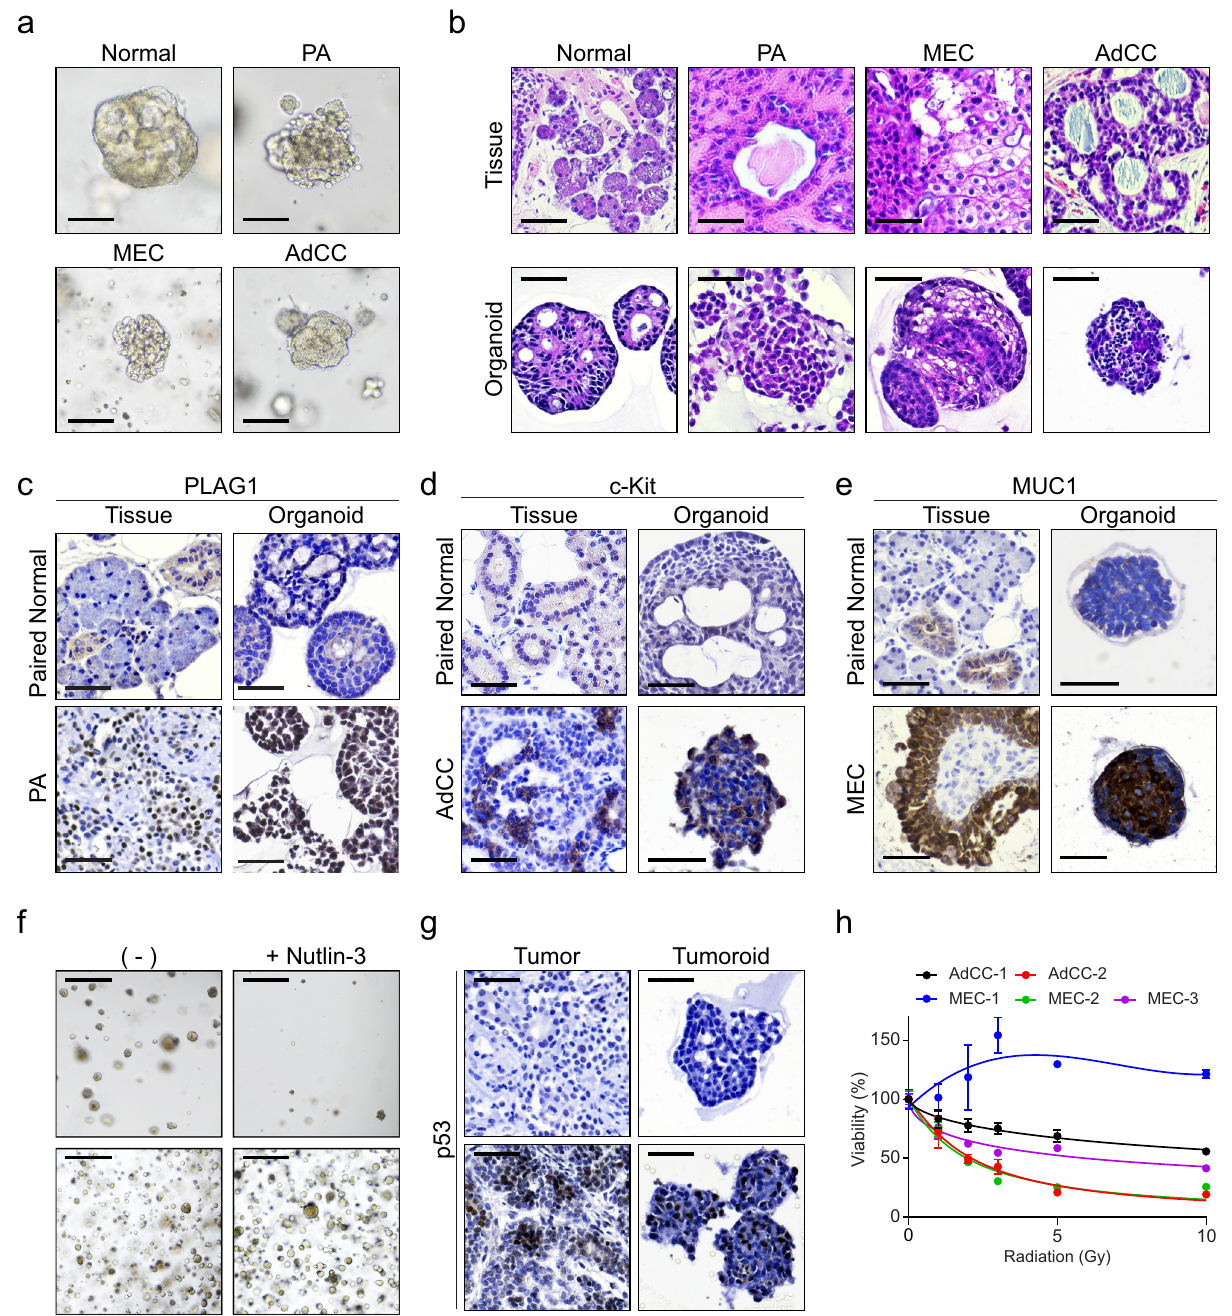
Fig. 6 Tumor-speci fi c features were conserved in tumoroid models. a – b Paired normal, pleomorphic adenoma (PA), mucoepidermoid carcinoma (MEC), and adenoid cystic carcinoma (AdCC) tissues were processed for organoid cultures. a Organoid growth was observed under a bright fi eld microscope after 2 weeks of culture in tumor-GEM. Scale bars indicate 100 μ m. b Histological examination was performed via H&E staining of tissues (top) and organoids (bottom). Scale bars indicate 50 μ m. c The PA-speci fi c expression of PLAG1 was assessed in tissues (left) and organoids (right) using immunohistochemistry (IHC) staining. Paired adjacent tissues with normal histology were used as control. Nuclei were stained with hematoxylin. Scale bars indicate 50 μ m. d The AdCC-speci fi c expression of c-Kit was assessed in tissues (left) and organoids (right) using IHC staining. Paired adjacent tissues with normal histology were used as control. Nuclei were stained with hematoxylin. Scale bars indicate 50 μ m. e The MEC-speci fi c expression of MUC1 was assessed in tissues (left) and organoids (right) using IHC staining. Paired adjacent tissues with normal histology were used as control. Nuclei were stained with hematoxylin. Scale bars indicate 50 μ m. f , g Tumoroids were cultured with or without the p53 inhibitor nutlin-3 (10 μ M) for 5 days. Nutlin-3-sensitive (top) or -resistant (bottom) organoids were assessed for growth under a bright fi eld microscope f while the expression of p53 was evaluated via IHC g . Nuclei were stained with hematoxylin in IHC data. Scale bars indicate 500 μ m in ( f ) and 50 μ m in ( g ). h Diverse sensitivity to radiation was observed in MEC or AdCC tumoroids. Cell viability was assessed at 1, 2, 3, 5, and 10Gy ( n = 5). Cell viability of tumoroids without irradiation was normalized as 100% viability. Data are representative of at least three independent experiments. Source data are provided as a Source Data fi